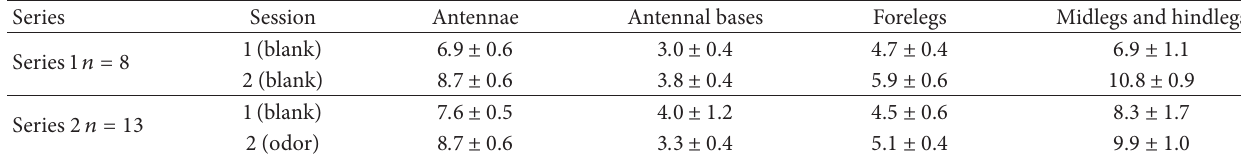
Table 4: Duration of a single grooming event (s). Mean ± standard error.